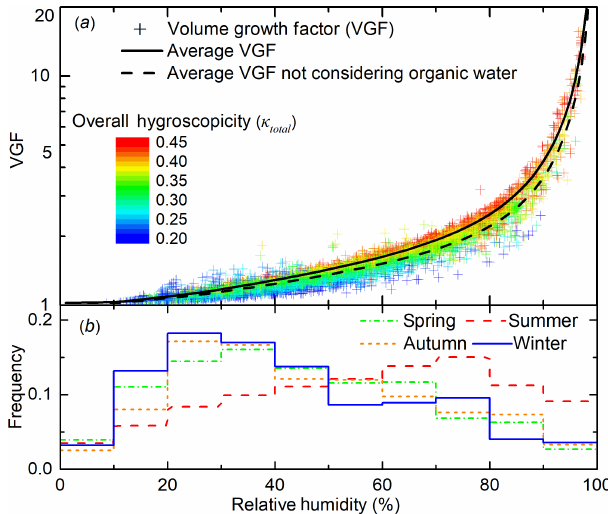
Figure 5. (a) Volume growth factor (VGF, scattered points, calcu- lated by Eq. 3) from the four seasons as a function of relative humid- ity (RH). The points are coloured by overall particle hygroscopicity ( κ total ) calculated from aerosol bulk composition (Eq. 4). The black line is the averaged VGF at a different RH. Black dashed line is the average VGF without considering organic water. (b) RH frequency during four seasons is expressed as a step